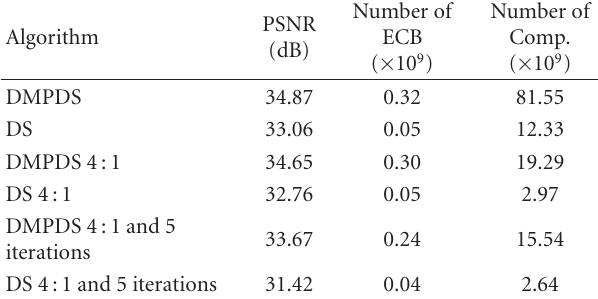
Table 2: Average results for DMPDS and DS with iteration restrictions and